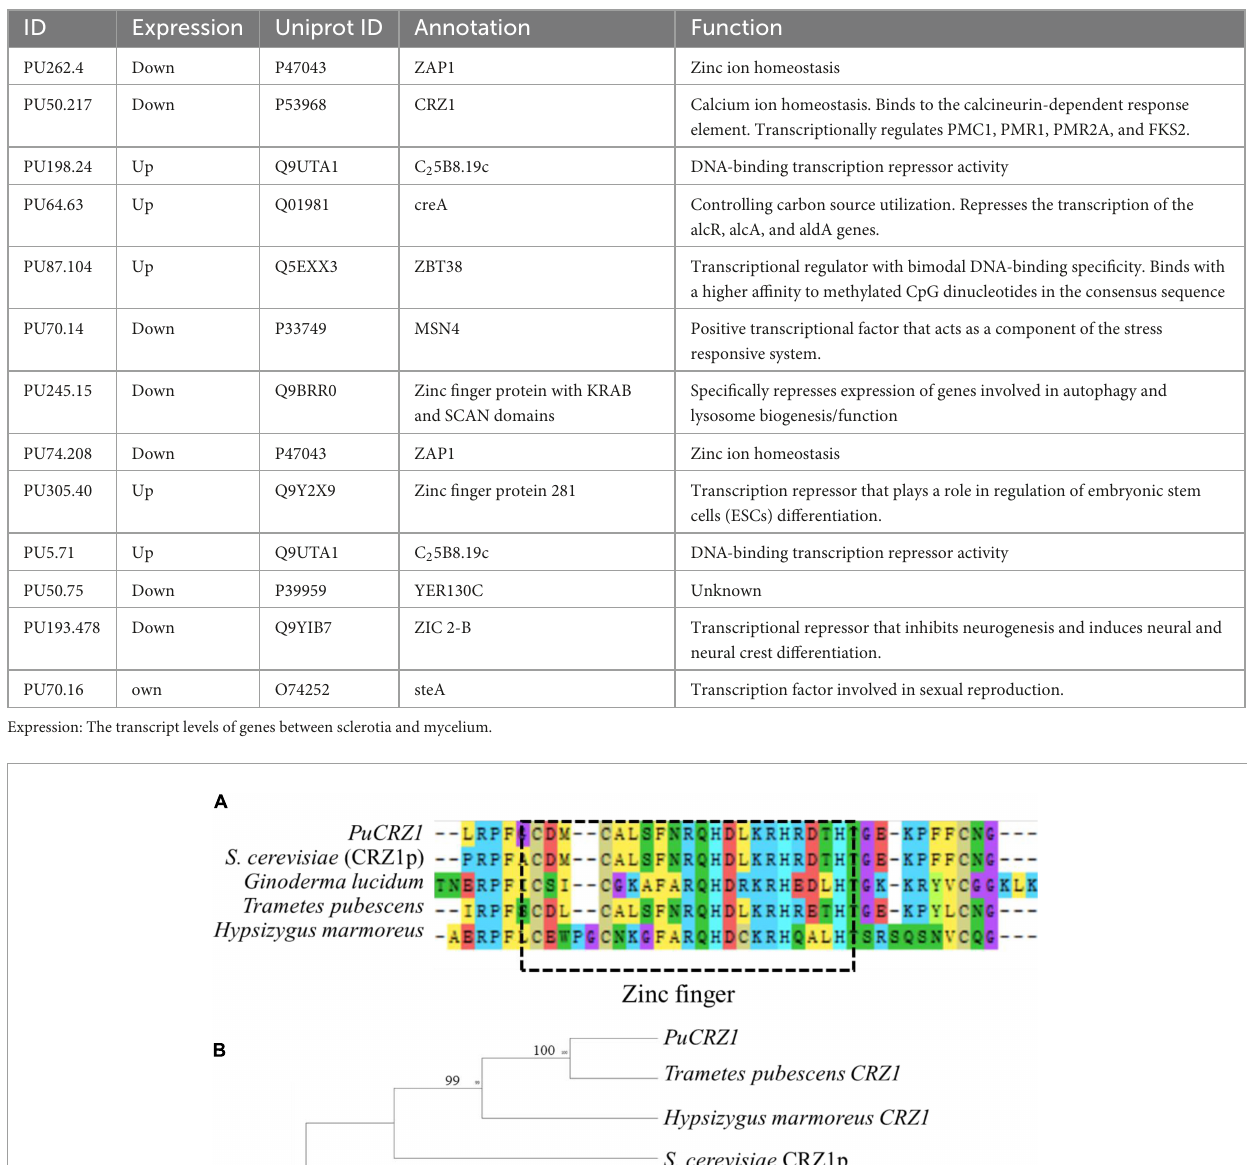
TABLE 2 C2H2 family genes were differentially expressed in sclerotia and mycelia.